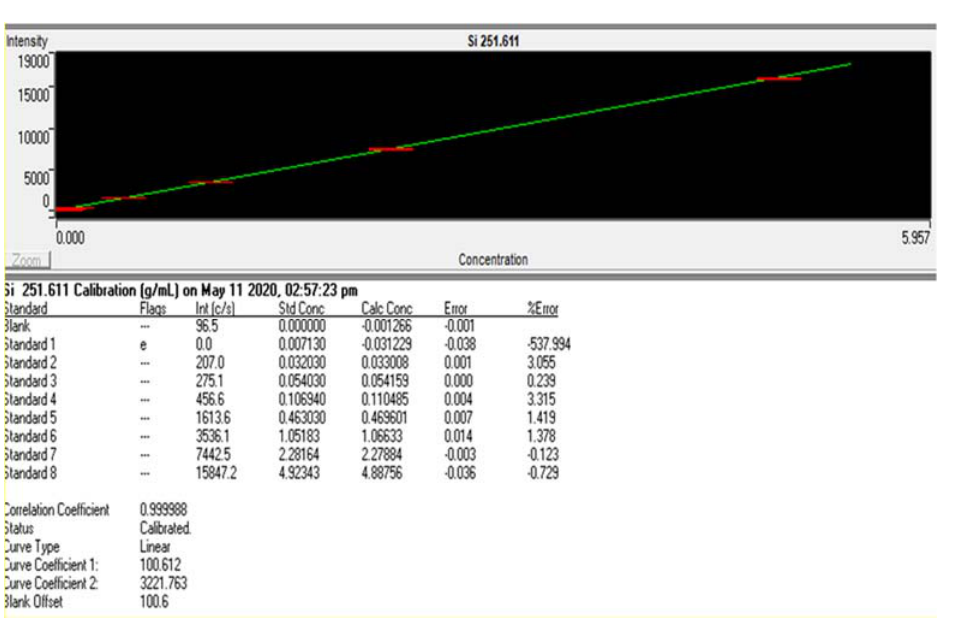
Figure 2. A representative Si-standard curve. Screenshot from the ICP Expert program (Agilent) showing the Si-standard curve with its calculated parameters.